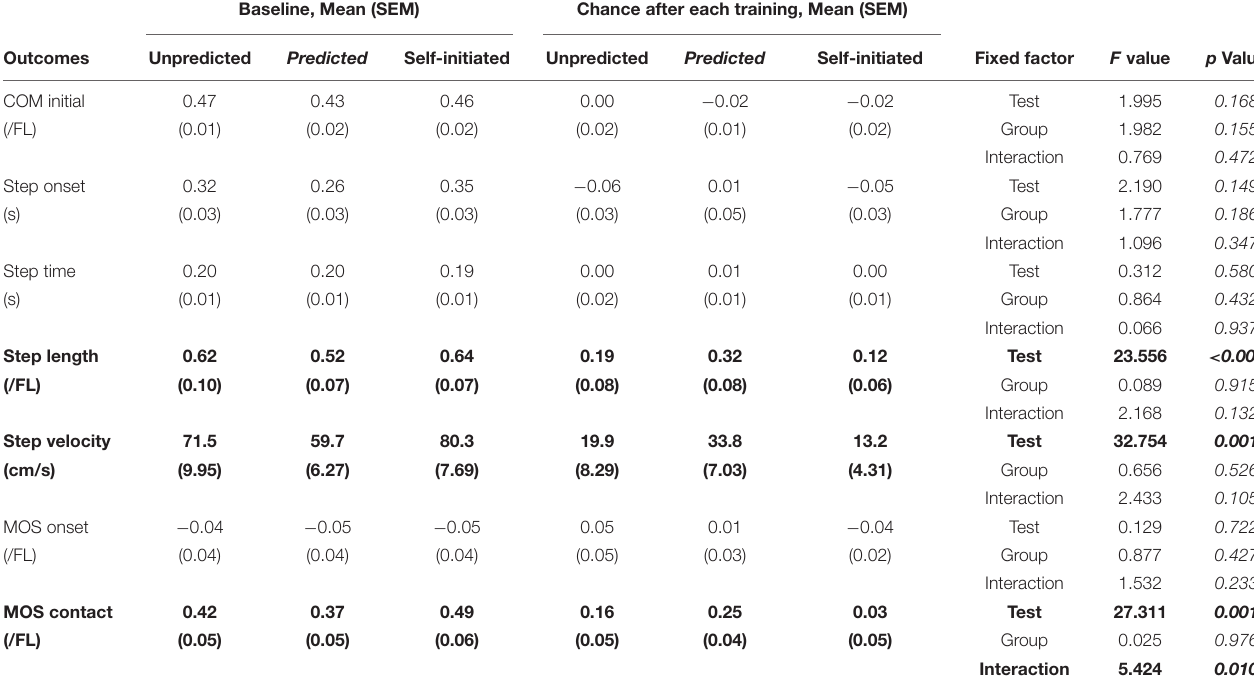
TABLE 2 | Results from the two-way mixed-design analysis of variance for each step measure. Baseline, Mean (SEM) Chance after each training, Mean